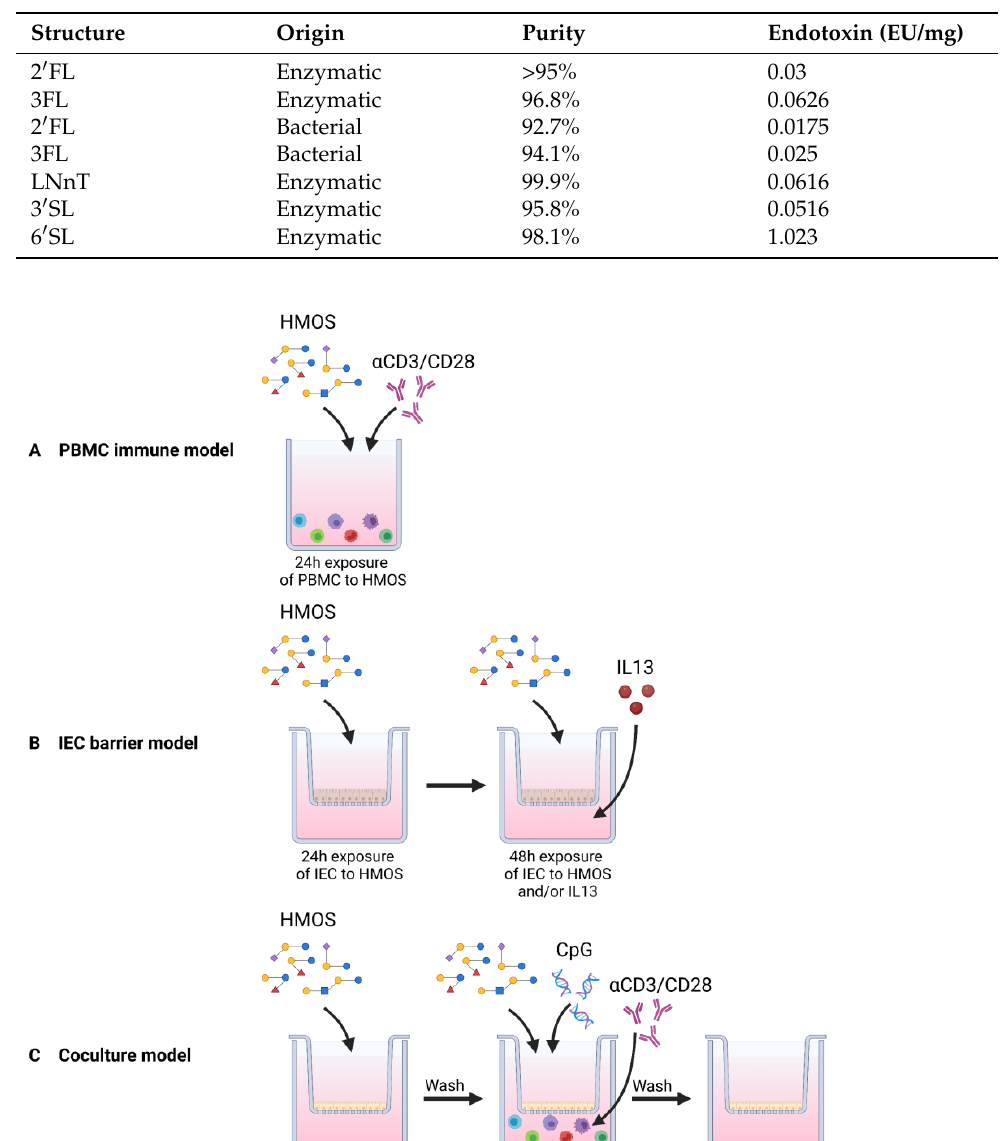
Table 1. Origin, purity and endotoxin content of the HMOS used in the experiments. Structure